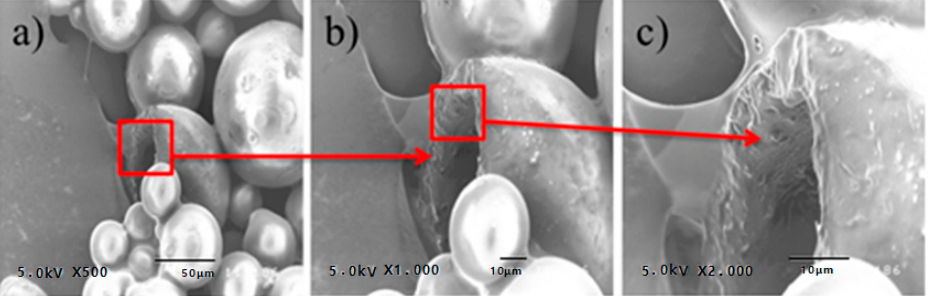
Figure 1. SEM images of ( a ) cross-section of microcapsule, ( b ) distribution of nanoparticle (NPs) encapsulated, and ( c ) zoomed-up image of NPs (Alginate NPs). Red square and arrow mean zoomed-up area of previous image.